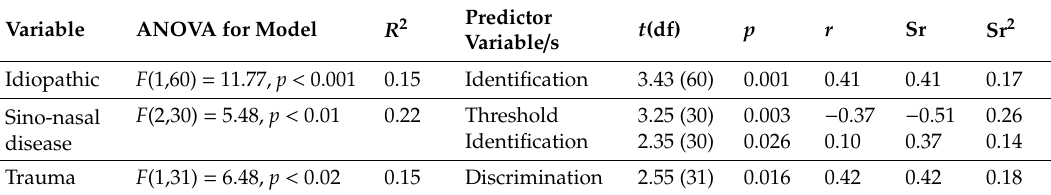
Table 4. Stepwise regression analyses, with Western-style diet score as the dependent variable, and age, gender, duration of the problem, identification, discrimination and thresholds scores as